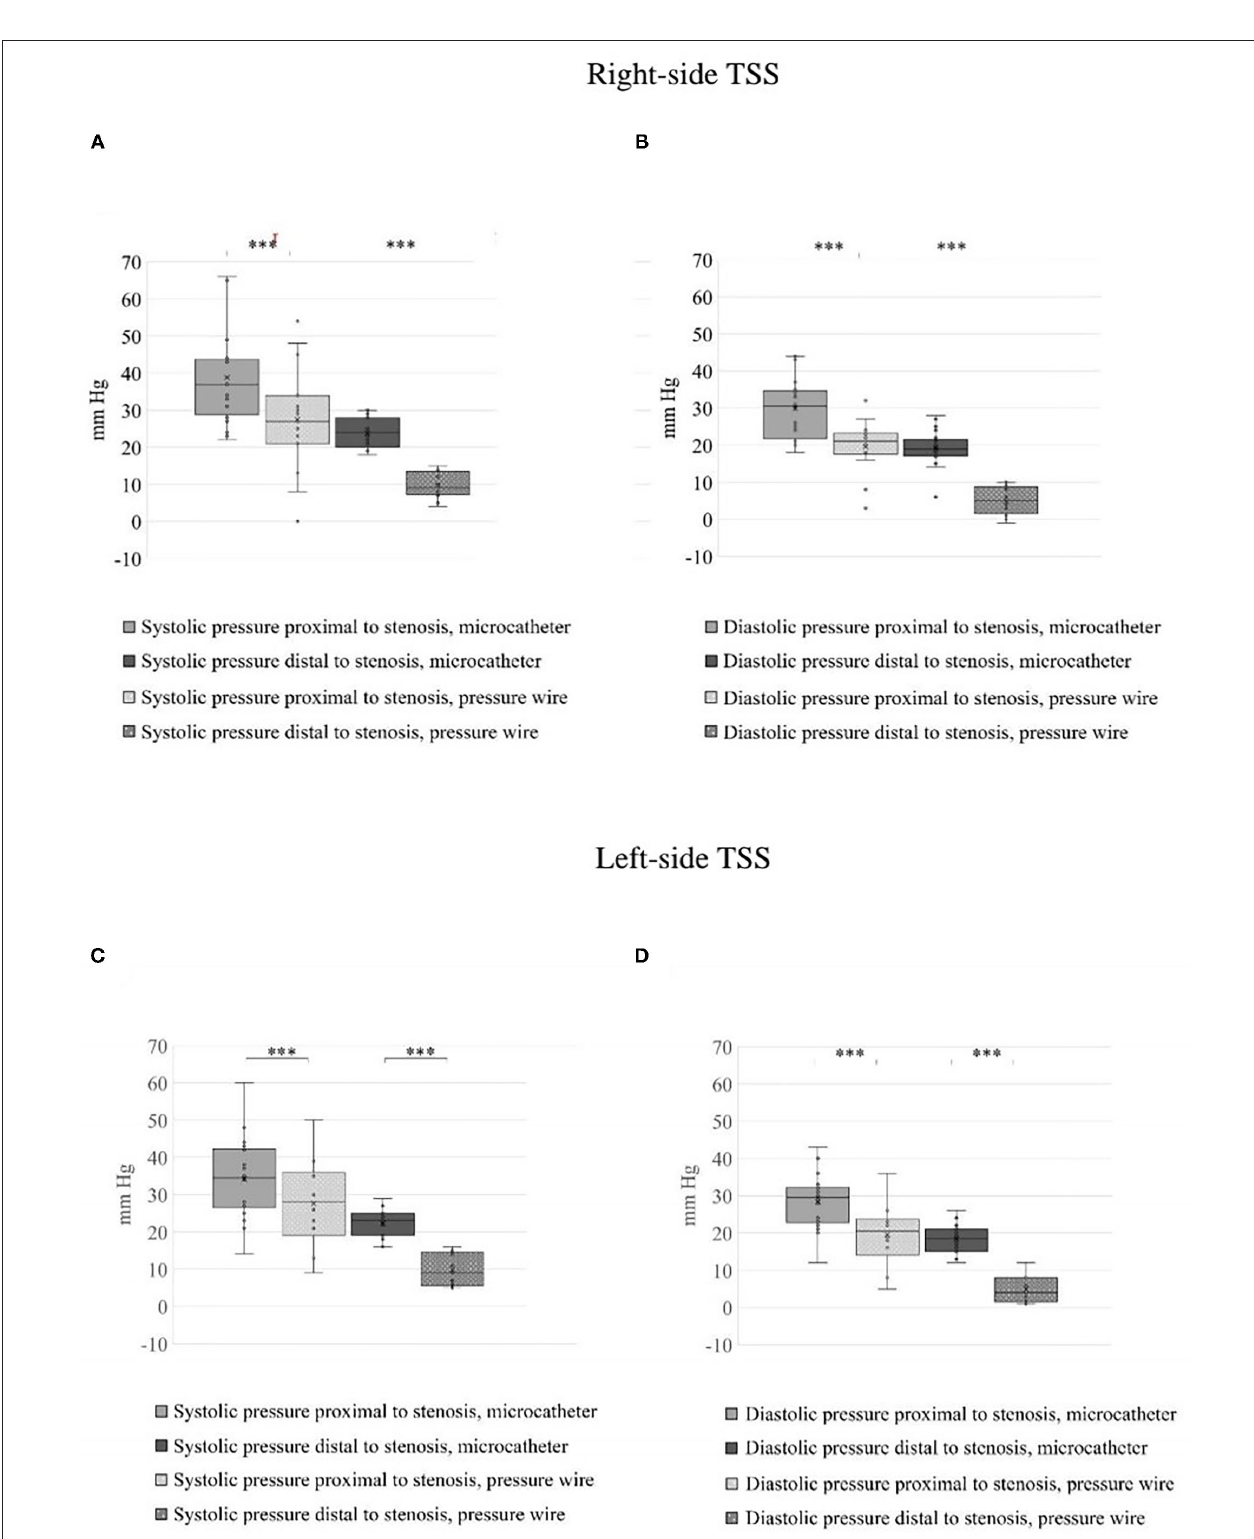
FIGURE 2 | Estimated blood pressure across the stenosis on both sides before treatment. (A) Right systolic venous pressure (SVP) and (B) right diastolic venous pressure (DVP) across the stenosis obtained by the microcatheter and pressure wire. (C) Left SVP and (D) left DVP across the stenosis obtained by the two measurements systems. The blood pressure range measured by the two methods, for all the cases tested, differ significantly, *** p < 0.001.